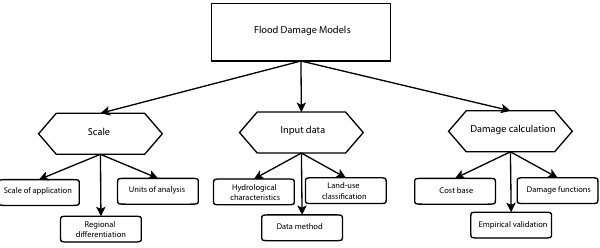
Fig. 3. Schematic display of the framework for qualitative assess- ment of the damage models included in this study. The summarised results are listed in Table